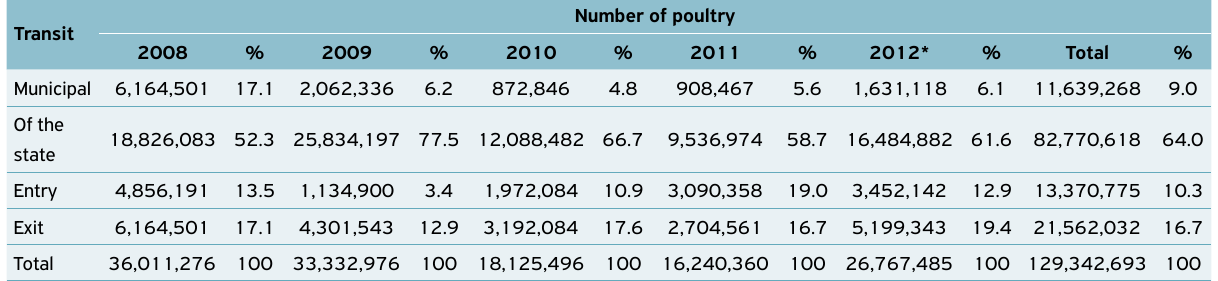
Table 1. Poultry transit recorded in the state of Sergipe, Brazil, from 2008 to 2012.